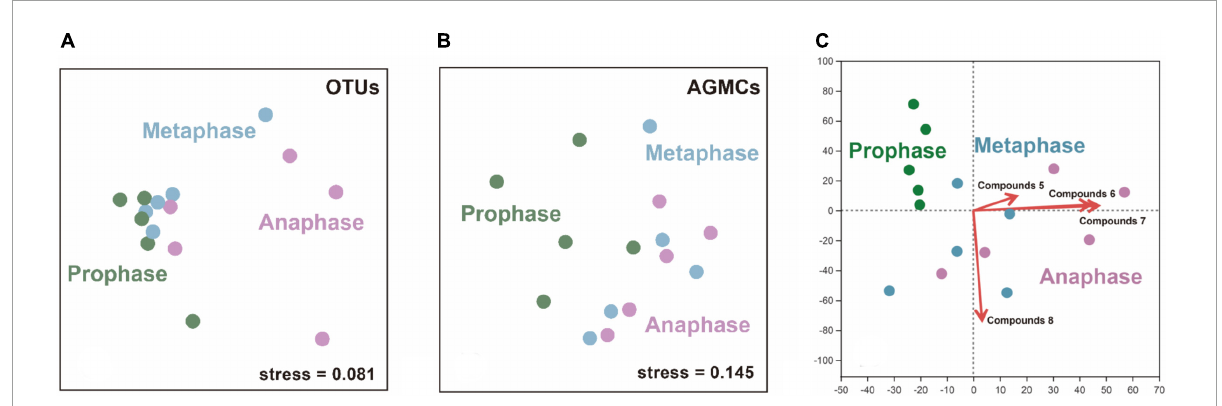
FIGURE6 The differences and correlation between different estrus phases of adult female pandas in the microflora (OTUs) and anogenital gland secretion compounds (AGMCs). (A) An nMDS plot showing a difference in structure between the AGM bacterial communities of adult female giant pandas at prophase, metaphase and anaphase of estrus ( n = 15). (B) An nMDS plot showing a difference in structure between the AGMCs profiles of adult female giant pandas at prophase, metaphase and anaphase of estrus ( n = 15). (C) A redundancy analysis (RDA) plot showing a correlation to the AGM compounds and AGM bacterial communities of different estrus phase ( n = 15). Compounds 5-8 represent: hexadecanoic acid ethyl ester, ethyl 9-hexadecenoate, ethyl oleate and squalene,